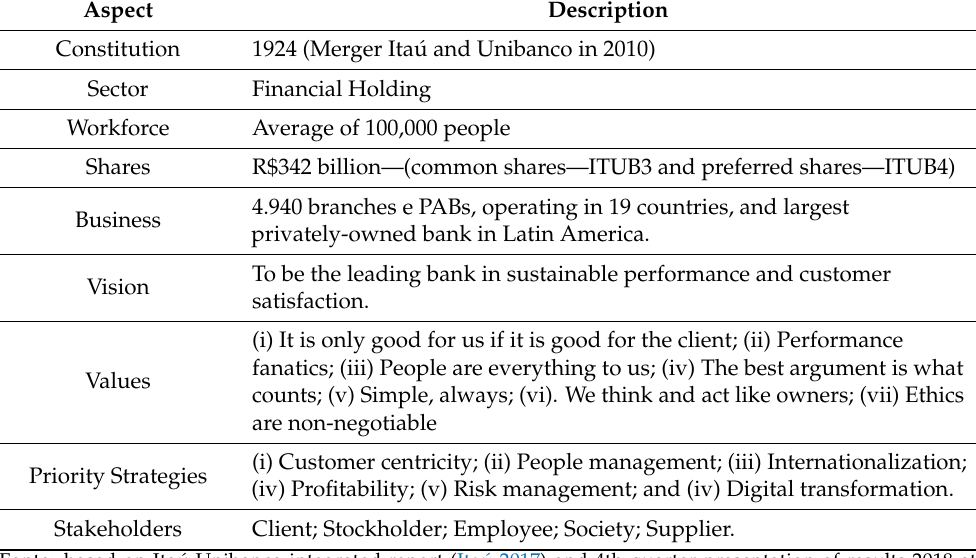
Table 2. Ita ú ’s main